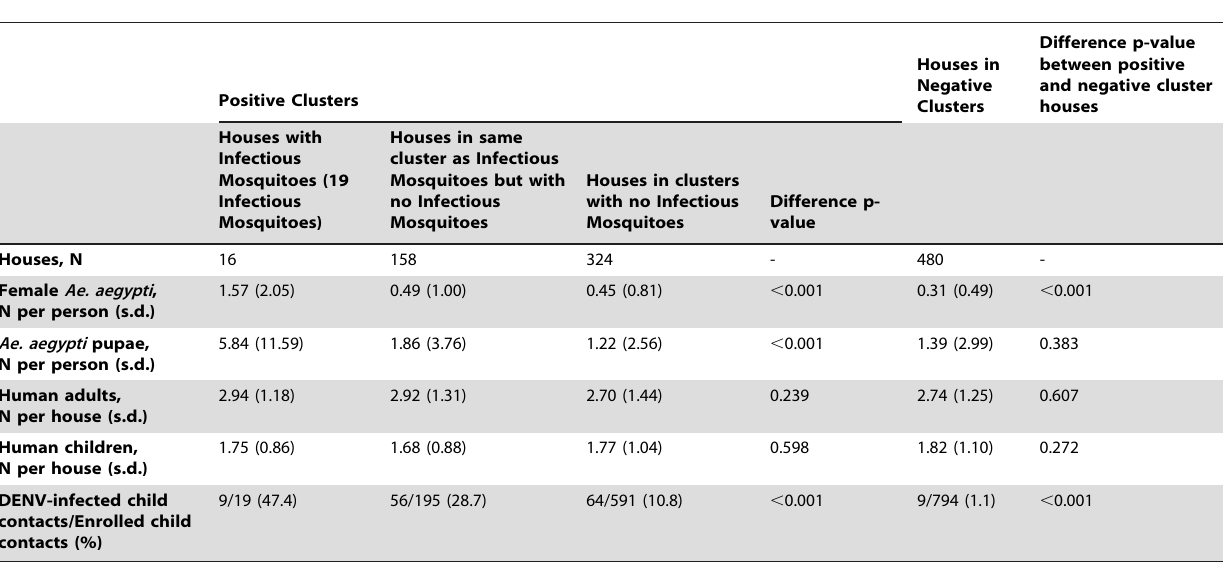
Table 3. Selected entomological indices and DENV infection rates in houses with and without infectious mosquitoes.